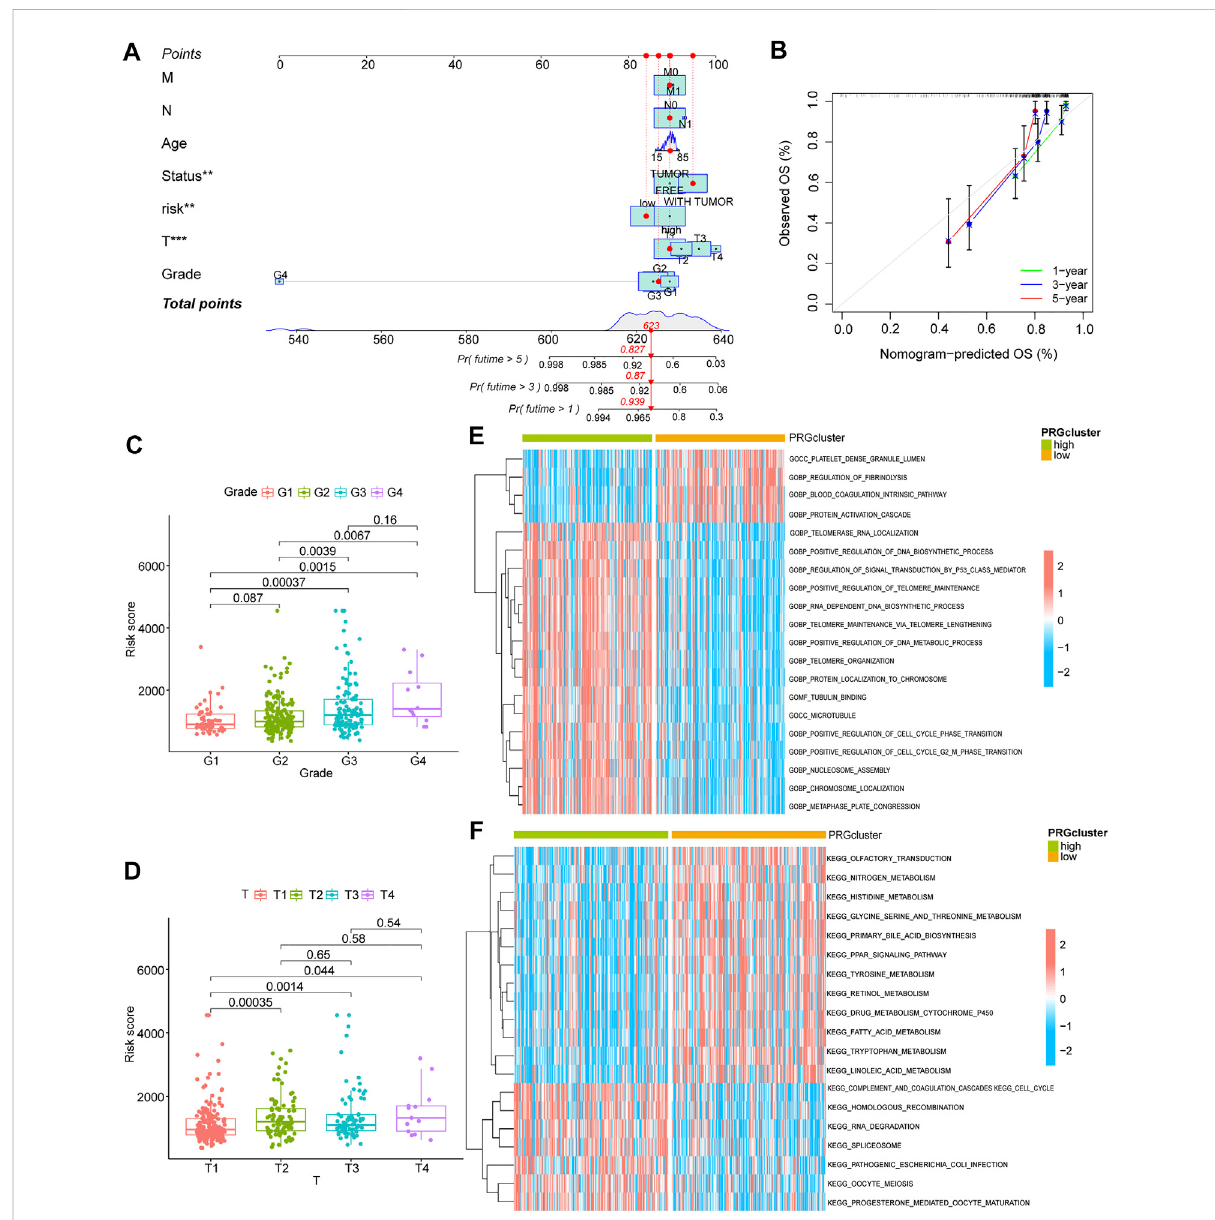
FIGURE 3 ClinicalanalysisandGSVAanalysisoftheprognosticmodel. (A) riskscorecombinedwithclinicalindicatorstodrawnomogram; (B) comparison ofpredictedsurvivaltimeandactualsurvivaltimeusingnomogram; (C,D) :correlationanalysisforG-stageandT-stage,respectively; (E,F) :GSVA-GO analysis (E) and GSVA-KEGG analysis (F) for high and low-risk